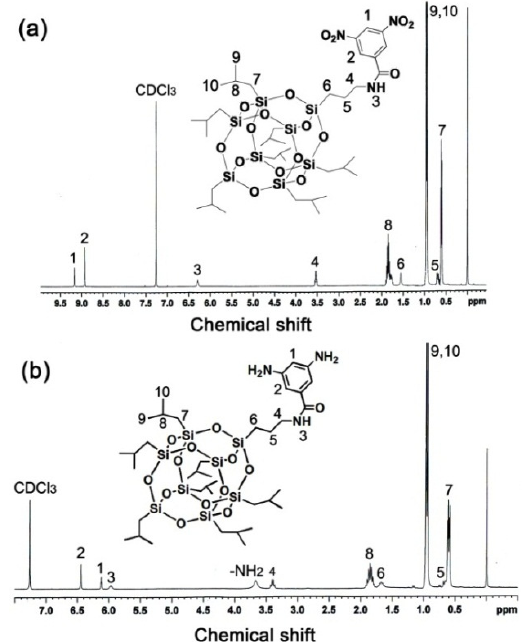
Figure 2. 1 H-NMR spectra of the chemical compounds. ( a ) N -[(heptaisobutyl-POSS)propyl]-3,5- Figure 2. 1 H ‐ NMR spectra of the chemical compounds. ( a ) N ‐ [(heptaisobutyl ‐ POSS)propyl] ‐ 3,5 ‐ dinitrobenzamide (DNBA-POSS); and, ( b ) dinitrobenzamide (DNBA ‐ POSS); and, ( b ) DABA ‐ POSS.